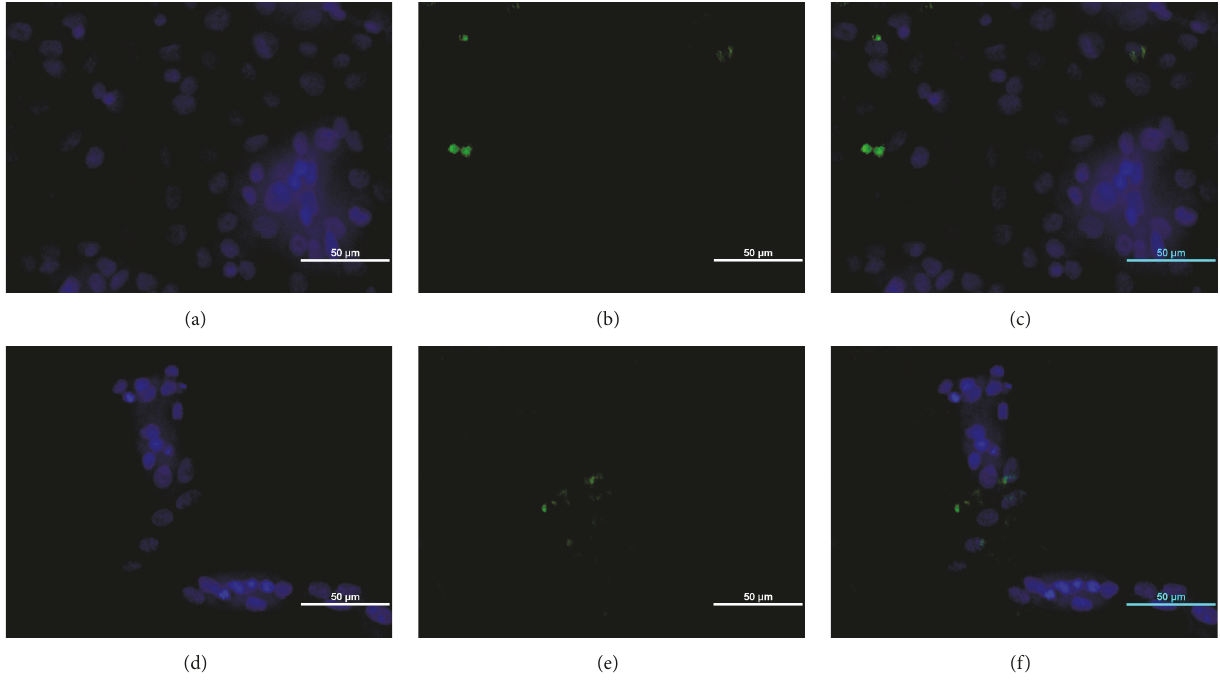
Figure 8: The indirect immunofluorescence test on the flask propagated UPM0081BGMP15 and UPM190BGMP15 showing low amount of IBDV antigen within the cytoplasm of infected BGM-70 cells at 72 hours after inoculation. ((a) to (c)) BGM-70 cells infected with flask propagated UPM0081BGMP15 and ((d) to (f)) UPM190BGMP15 showing positive signals for VP2 antigen (green) when stained with FITC-conjugated anti-chicken antibody raised against chicken anti-VP2 antibody. Bar=50 𝜇